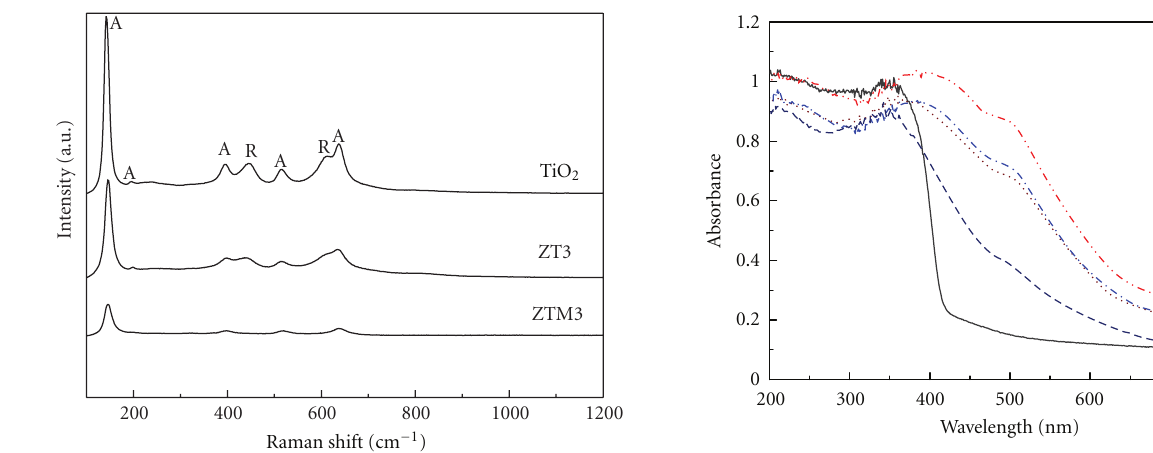
Figure 11: Raman spectra of di ff erent samples. (A: anatase, R: rutile.)